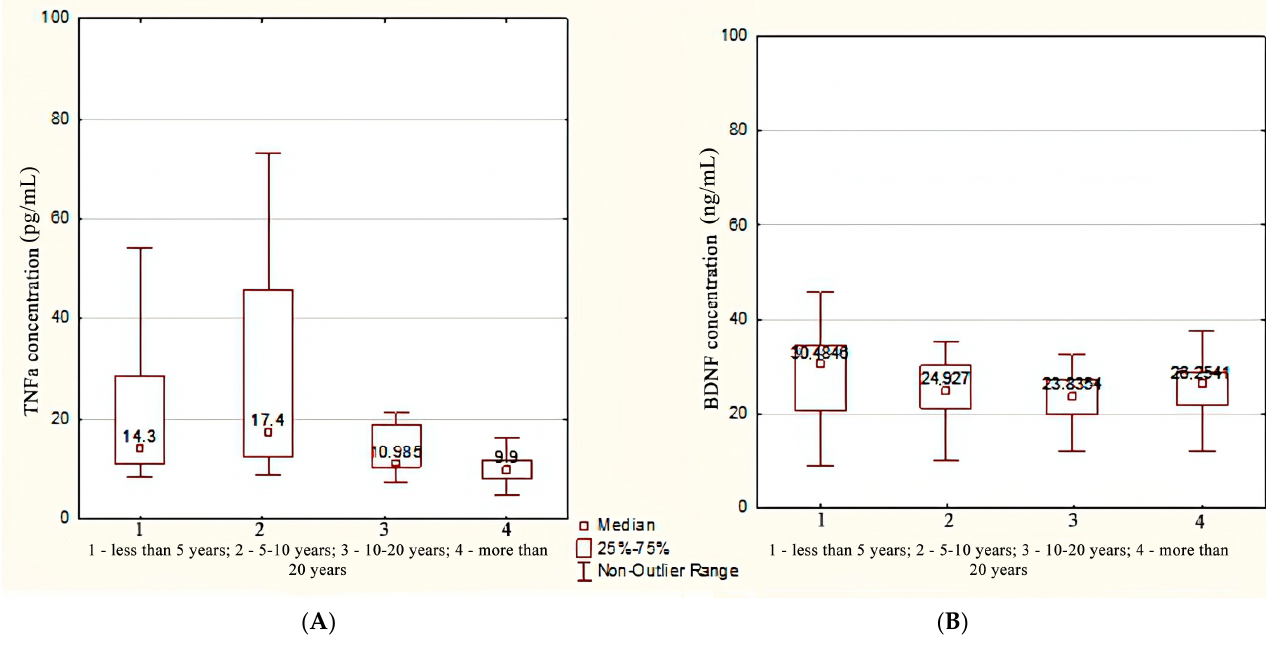
Figure 2. The concentration of TNFa ( A ) and BDNF ( B ) depending on the duration of TLE.